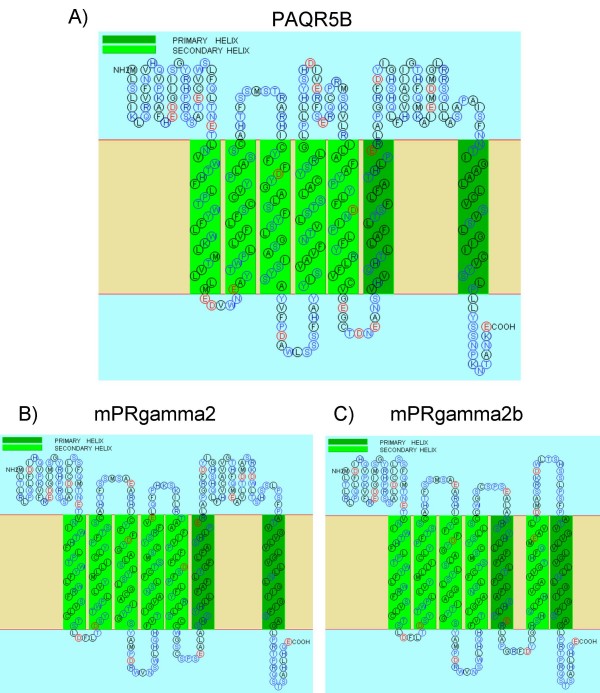
Predicted secondary structure of membrane progestin receptors from the fish olfactory epithelium. Snake-plot of complete PAQR5b and two mPRγ-2 splice variants from fish olfactory epithelia built using SOSUI prediction. Note that TM architecture remains despite significant rearrangement of transmembrane helices in case of mPRγ2b.